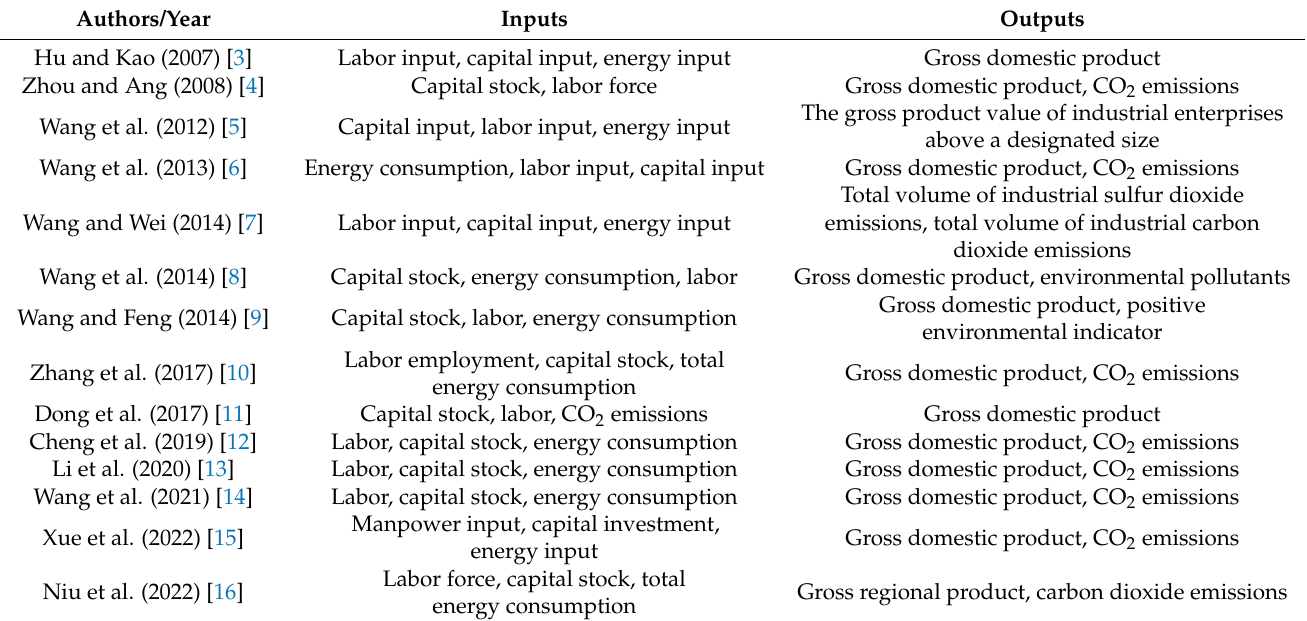
Table 1. Input and output indicators in some papers on low-carbon economic